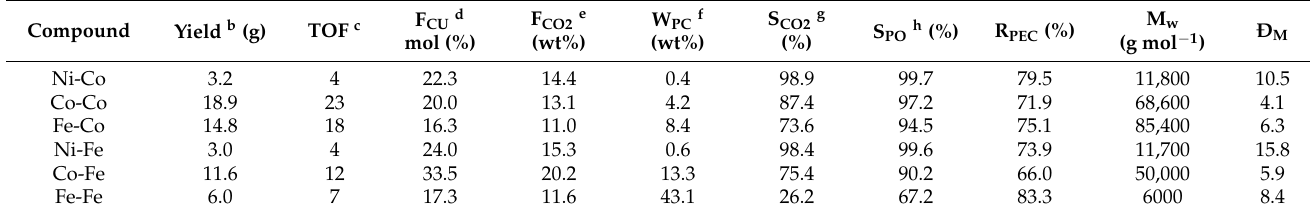
Table 9. Catalytic performance of the studied porous hexacyanometallates(III) a